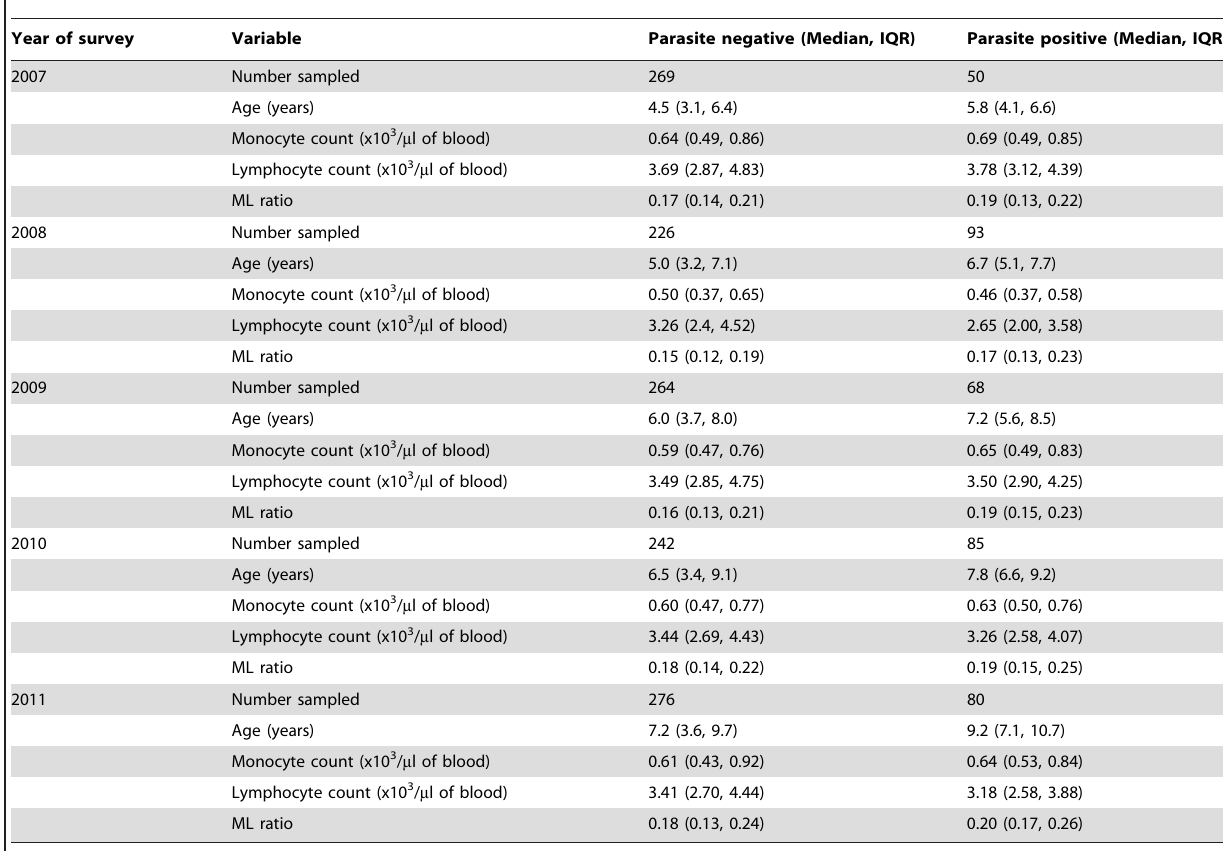
Table 1. Summary characteristics of the study